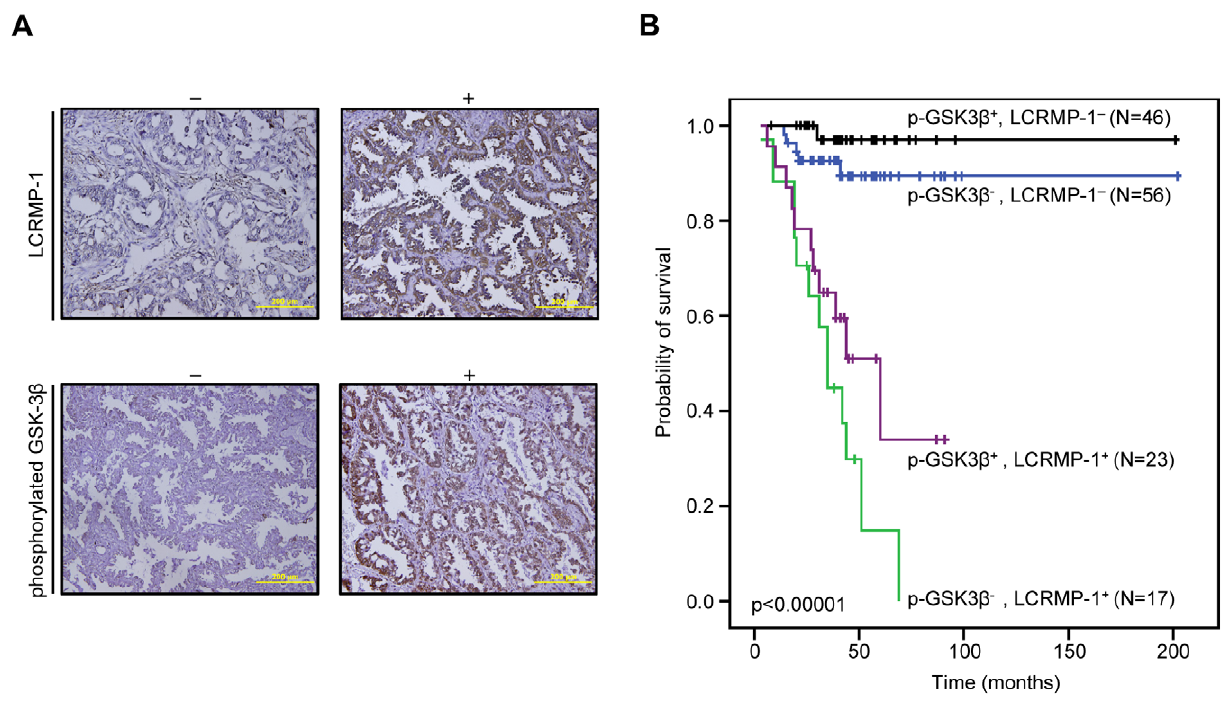
Figure 5. Kaplan-Meier survival plots for NSCLC patients grouped by phosphorylated GSK3 b and LCRMP-1 protein expression levels. (A) Typical protein expression patterns of phosphorylated GSK3 b and LCRMP-1 were detected by immunohistochemistry using anti-phospho- GSK3 b (Ser9) and anti-LCRMP-1 antibodies (C2) in serial dissections of primary tumor specimens from 142 NSCLC patients who underwent surgical resections. Results are shown + and 2 denotes tumors with and without over-expression with indicated protein respectively. Scale bars, 100 m m. p-GSK3 b was represented to phosphorylated GSK3 b . (B) Kaplan–Meier analysis of overall survival for 142 NSCLC patients with p-GSK3 b 2 -LCRMP-1 2 , p-GSK3 b 2 -LCRMP-1 + , p-GSK3 b + -LCRMP-1 2 , and p-GSK3 b + -LCRMP-1 + . P values were performed by 2-sided log-rank tests.